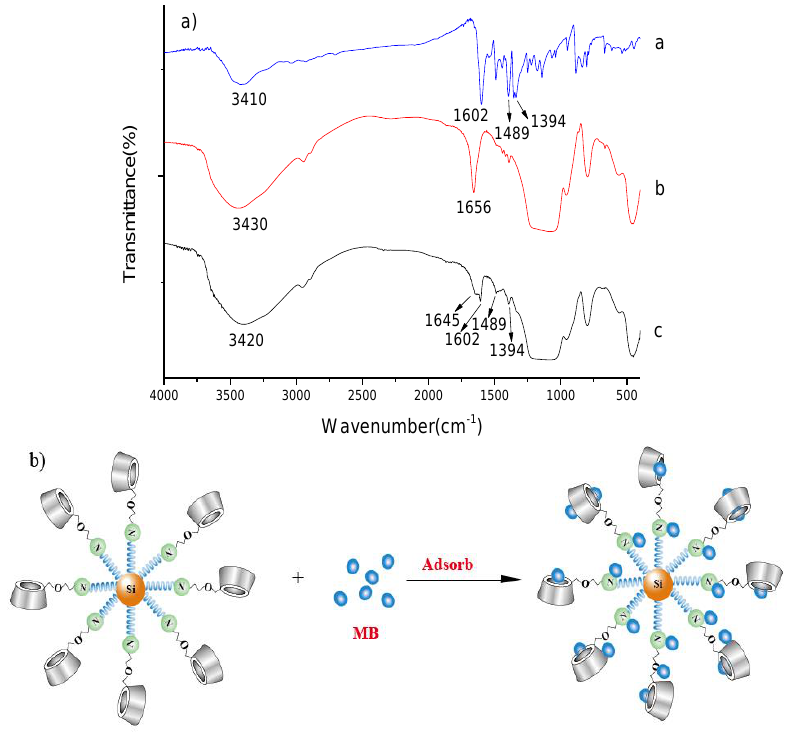
Figure 10. ( a ) FT-IR spectroscopy of (a) MB, (b) 6-EA-β-CD-Si, (c) 6-EA-β-CD-Si/MB; ( b ) Speculated adsorption mechanism of MB onto 6-EA-β-CD-Si. Table 5. Adsorption isotherms of MB on various